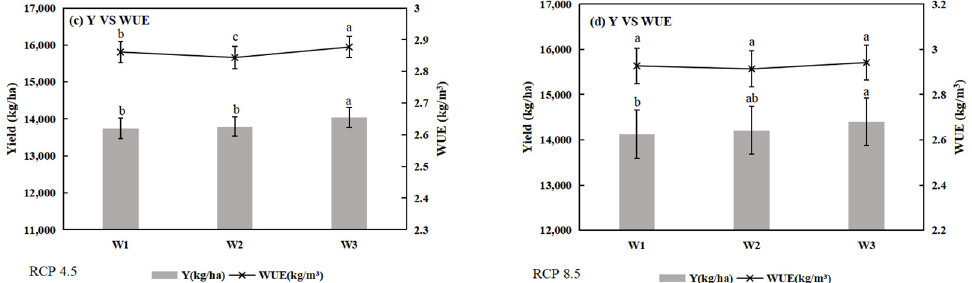
Figure 11. Relationship of Yield and WUE under different irrigation schedules. Different lowercase letters represent different levels of each column at p ≤ 0.5.